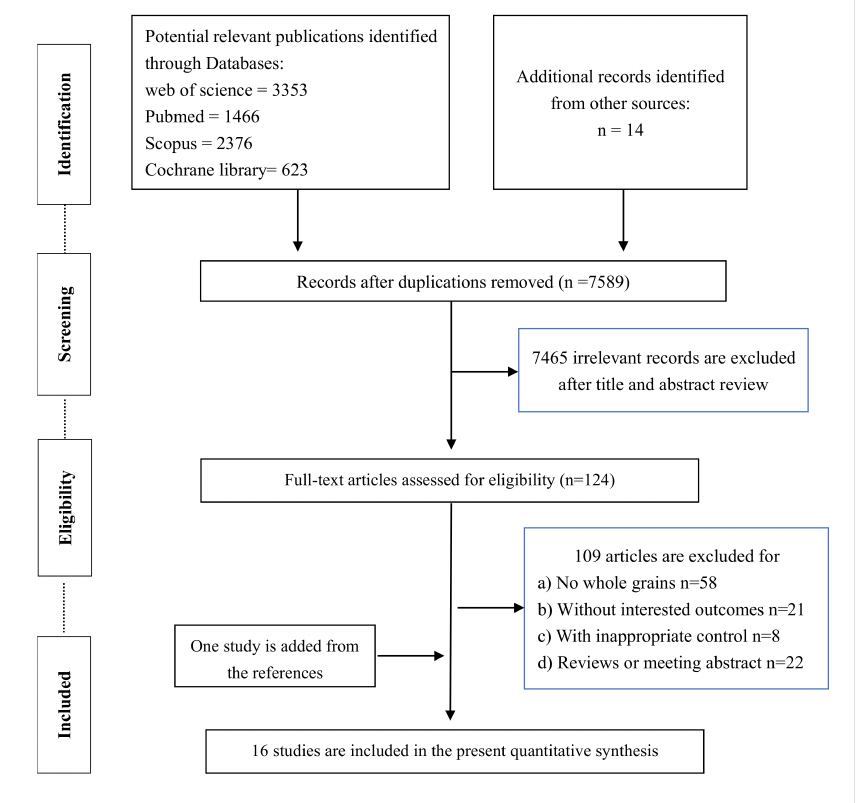
Figure 1. The flow diagram for selected